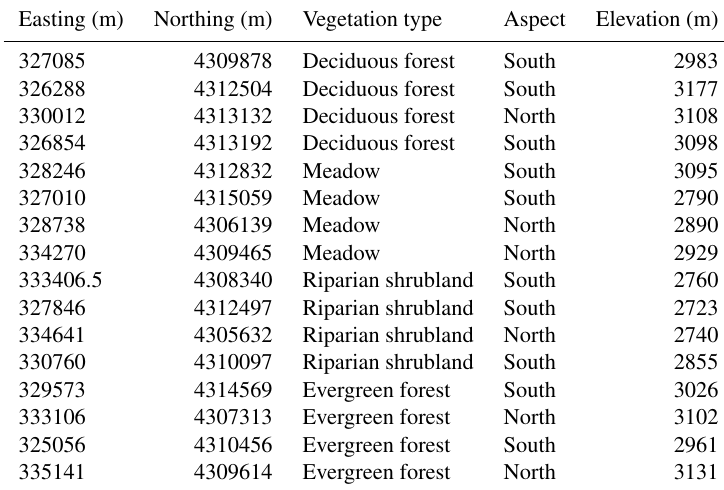
Table 2. Location and vegetation types of East River Watershed sampling points (Fig.